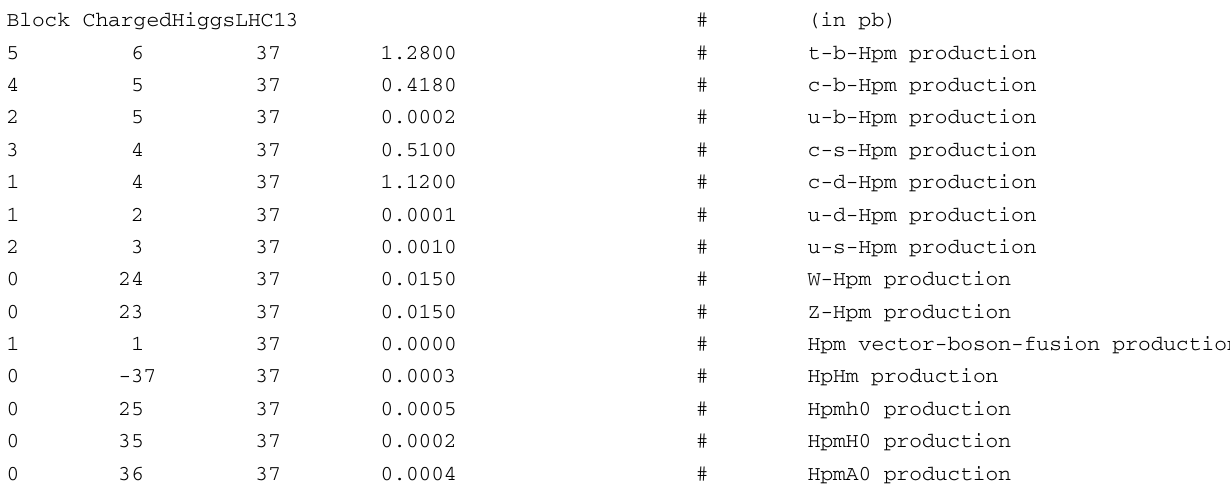
untagged jets. For the vector boson fusion process we set both quark PDG numbers to 1 in order to differentiate it from the other quark- associated production processes. All cross sections correspond to the sum of H + and H − production, hence, all PDG numbers are taken to be positive (except for H + H − production)